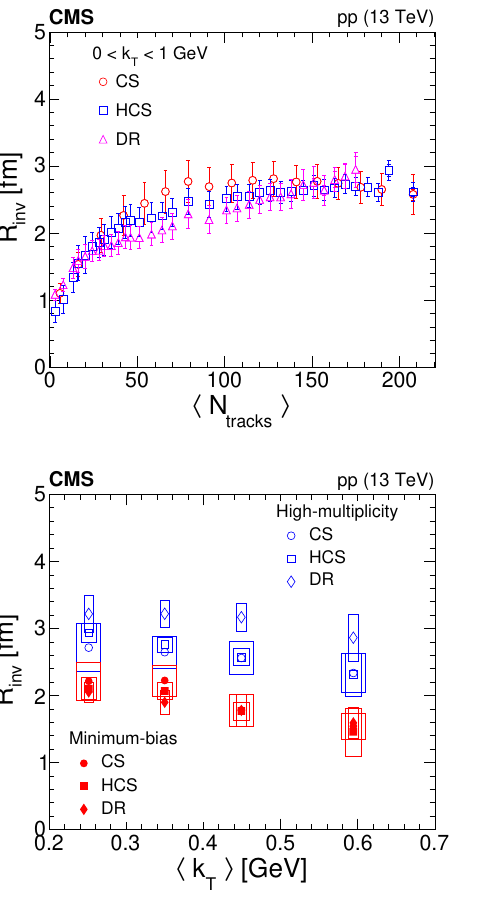
Figure 4 . Results for R (left) and (cid:21) (right) from the three methods as a function of multiplicity inv (upper) and k (lower). In the upper plots, statistical and systematic uncertainties are represented T by internal and external error bars, respectively. In the lower plots, statistical and systematic uncertainties are shown as error bars and open boxes,